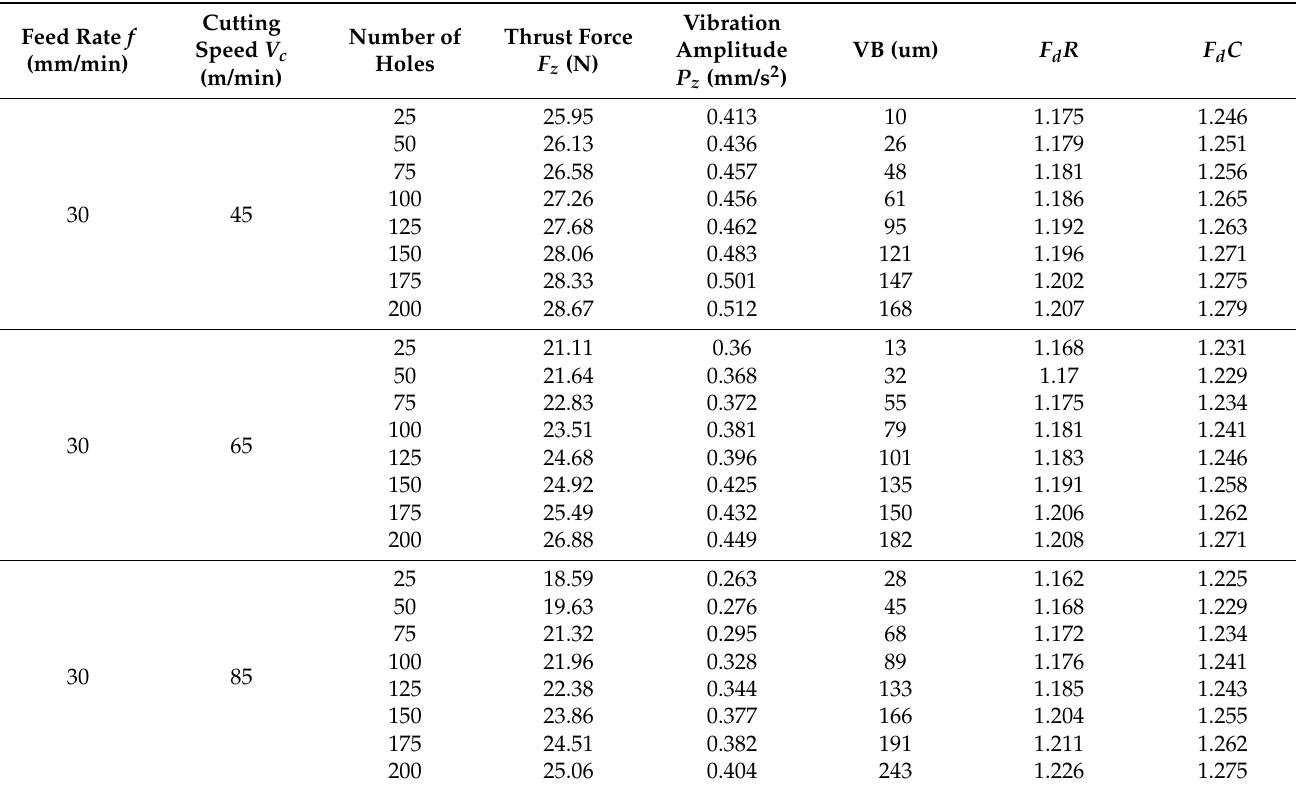
Table 3. Training data for the neural